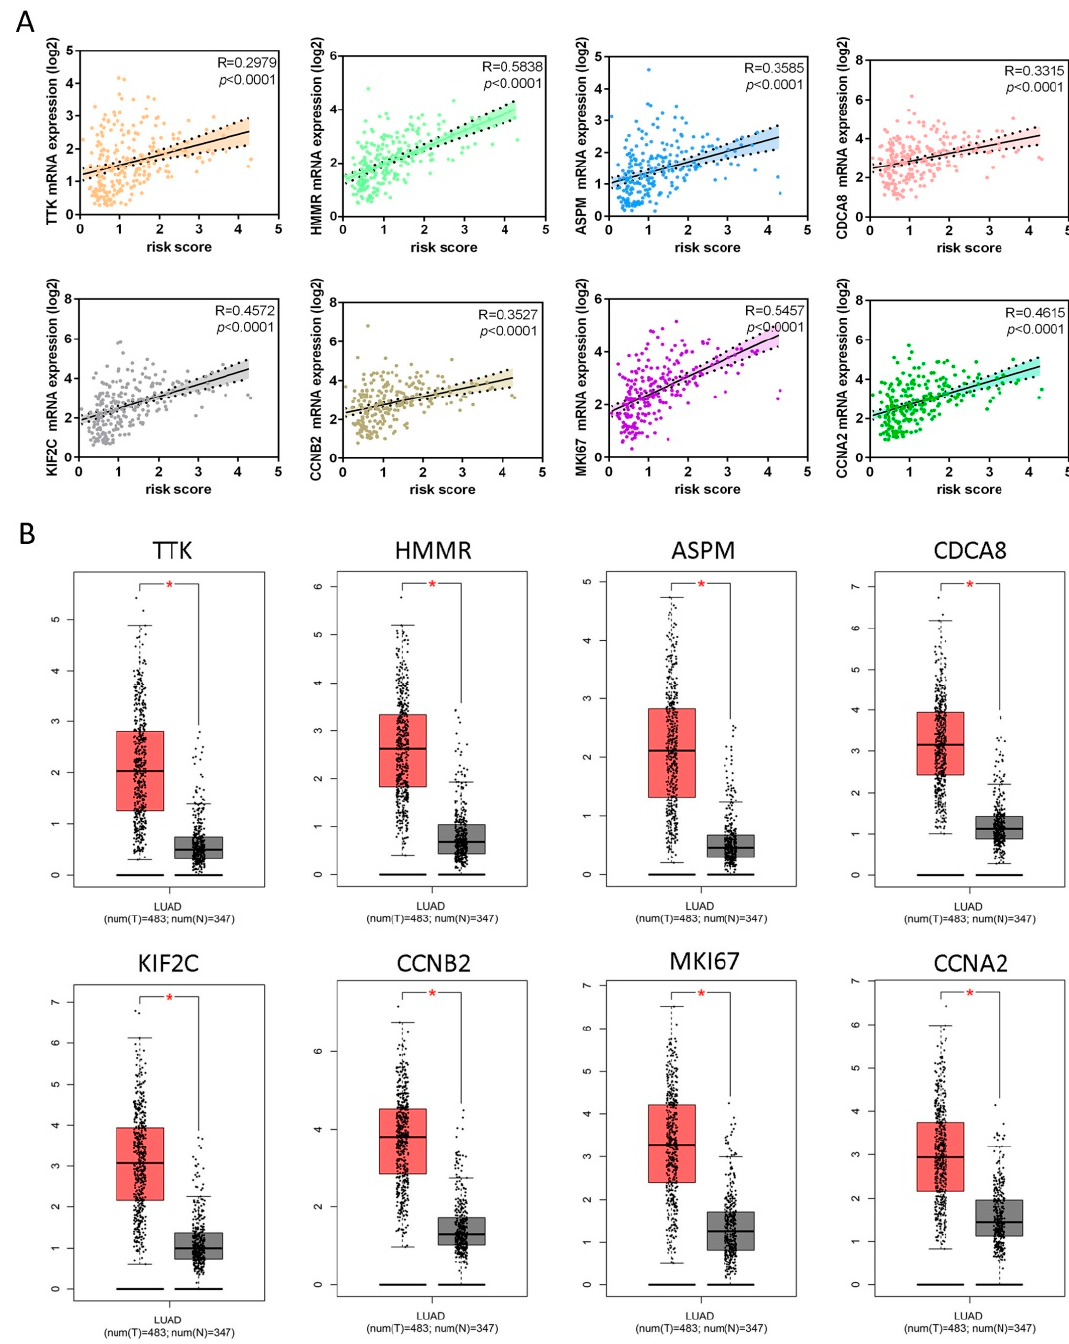
Figure 7. Validations of eight genes contained in the risk score model. ( A ) Scatter plots between mRNA expression of each gene (y-axis) and corresponding risk score (x-axis) in patients with LUAD for these eight genes, which showed significant positive Pearson correlation coe ffi cients. ( B ) Comparisons of mRNA expression levels of each gene in LUAD tissues versus normal lung tissues, respectively. All genes had higher expression levels in cancer tissues than in normal lung tissues. The red and gray boxes represent cancer and normal tissues, respectively. The red-marked asterisk indicates that the di ff erential expression of each mRNA is significant ( p <